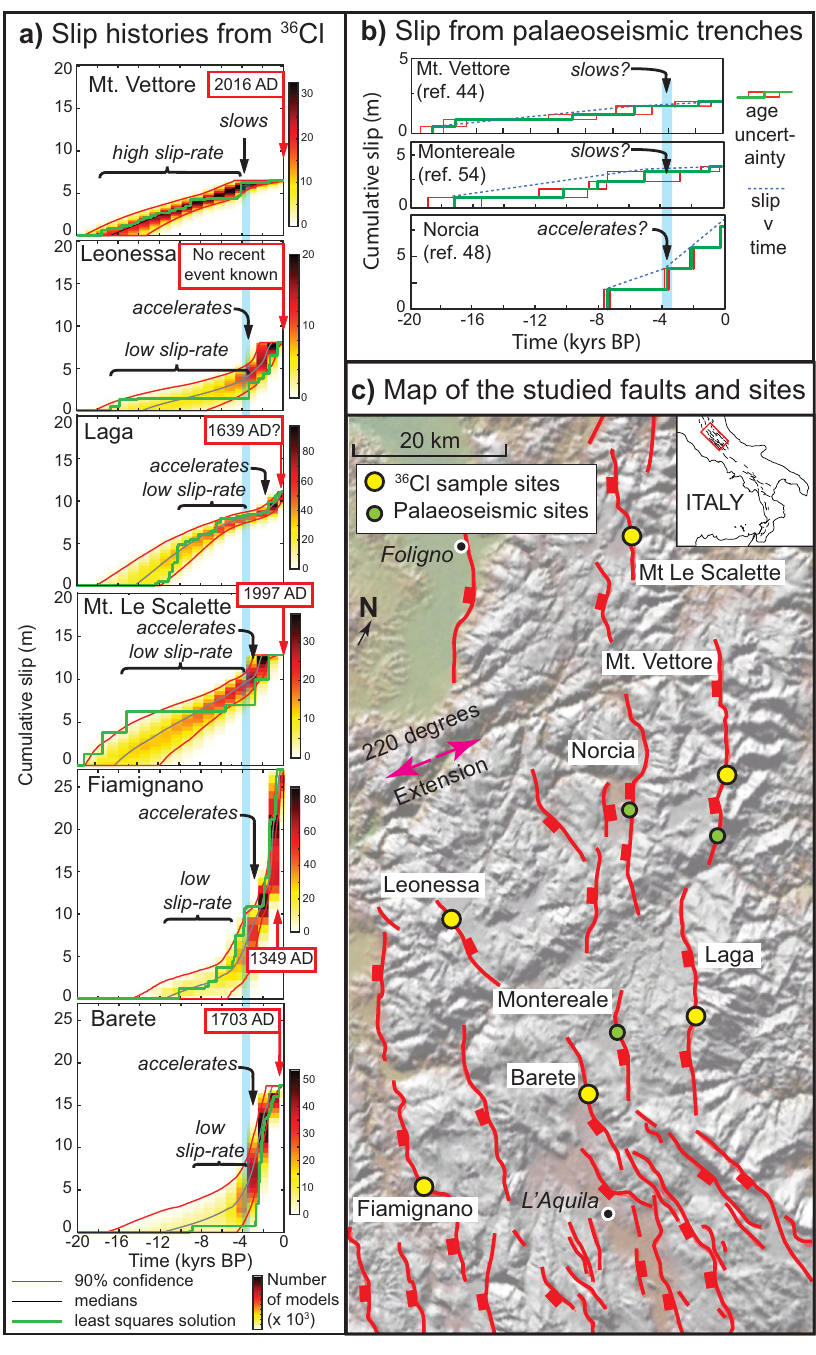
Fig. 5 | Slip histories for individual faults in the study region. a Slip histories derivedfrominsitu 36 Clcosmogenicexposuredataforthesixfaultsstudied.At~3.5 kyrsBP(~3.5ka),theleastsquaressliphistories,the ensembles of leastsquaresslip histories, and the 90% con fi dencebandsexhibitconvex upward shapesfor the Mt. Vettore fault, and convex downward shapes for all the other faults. Concavity and convexity indicate that slip-rates change for all the faults at ~3.5 kyrs B.P.; the Mt.